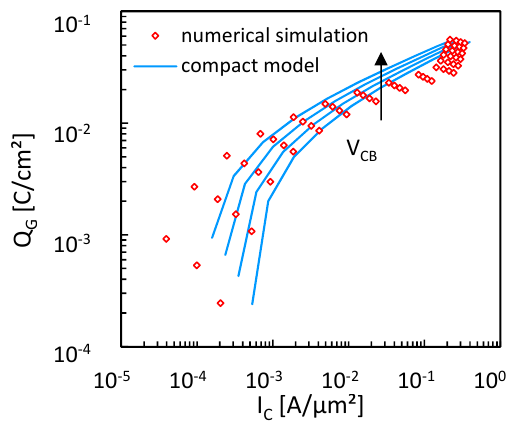
Figure 3. Charge Q G versus I CE curves for different V CB (2, 3, 4, 5 V), numerical simulation and compact model simulation.